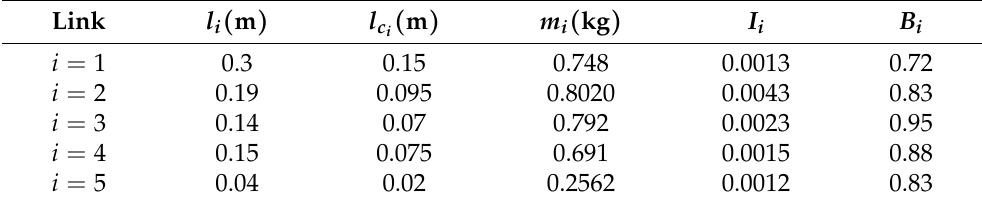
Table 1. Characteristics of 5-DoF robotic